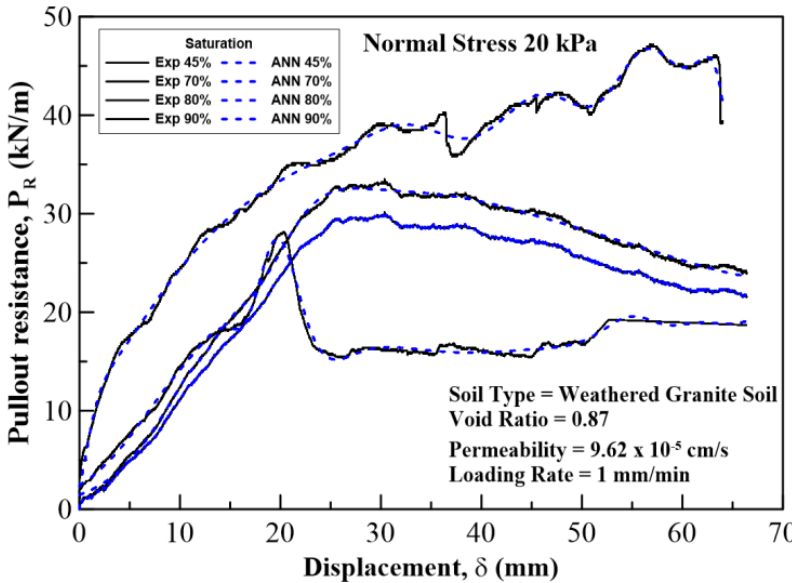
Figure 10. Pullout resistance vs. displacement curves plotted for a normal stress of 20 kPa at 45%, 70%, 80%, and 90% degree of saturation of the soil. Solid lines show experimental results, and the dotted lines show ANN results.